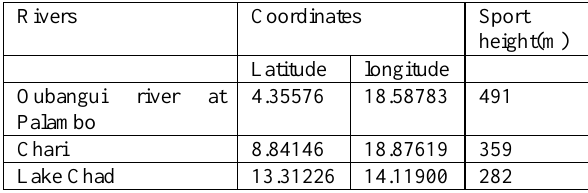
Table: 1 below illustrates the various coordinates and spot Height at the Oubangui River (Palambo), Chari and Lake